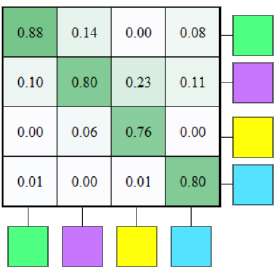
Table 3. Error Matrix; degradation mapping of stela M.E. 1357 through the Random Tree-based ML approach.